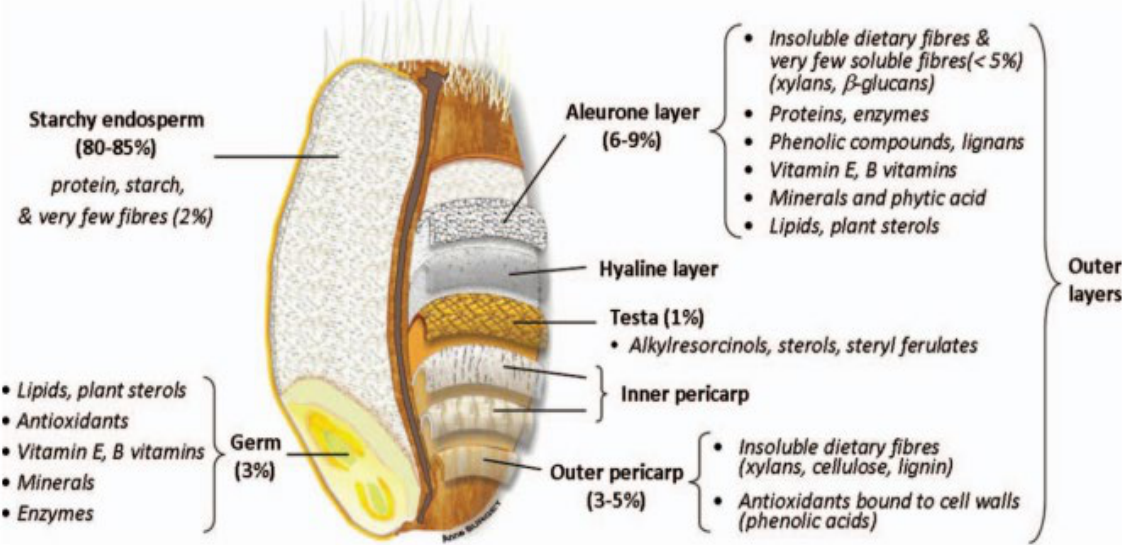
Figure 1. Wheat grain histology [10]. Adapted from Surget and Barron (2005) [21]. (Copyright for reprinting was requested and obtained through Taylor & Francis and Copyright Clearance Center.